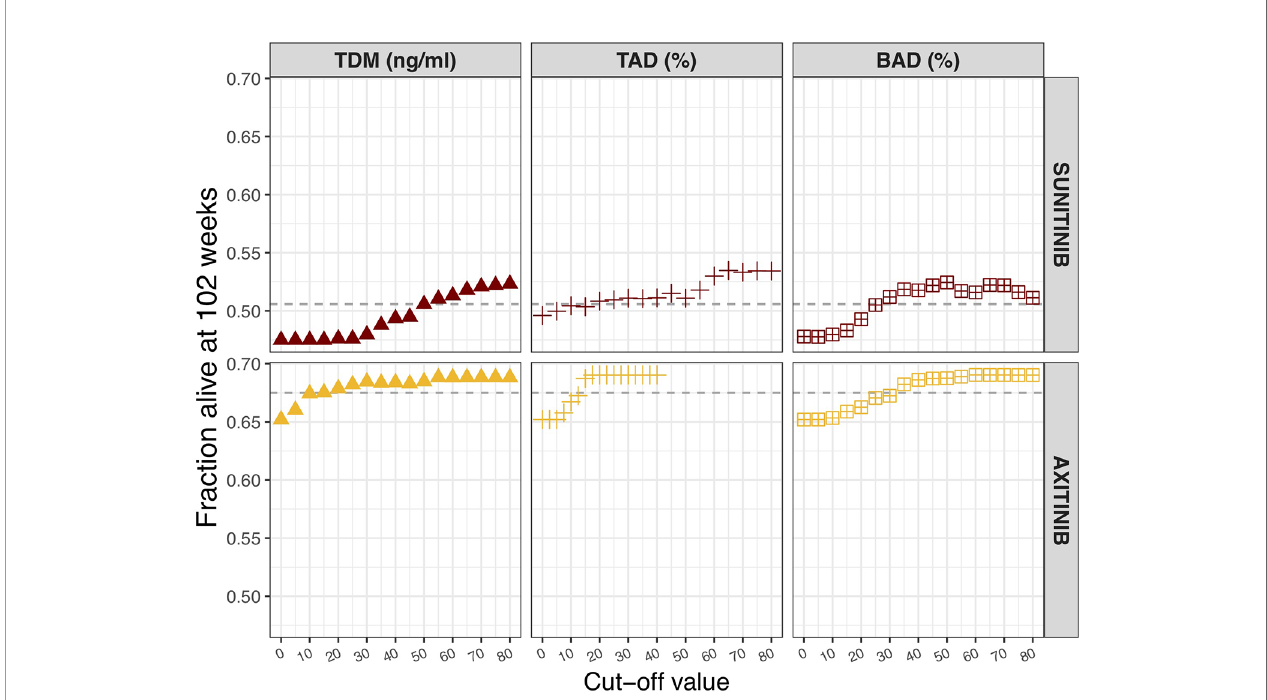
FIGURE 2 | In fl uence of biomarker threshold values on population overall survival at 102 weeks. For TDM of sunitinib (sunitinib and SU1266) and axitinib C trough,ss values of 0 to 80 ng/ml were assessed. For TAD based on neutrophils, a relative decrease from 0 to 80% from the population baseline value (5 × 10 9 cells/L) was evaluated. In case of TAD based on dBP, relative increase of 0 to 40% from individual baseline value was chosen. For BAD of sVEGFR-3, relative decrease from 0 to 80% of individual baseline value was assessed. BAD, biomarker-adjusted dosing; TAD, toxicity-adjusted dosing (ANC for sunitinib; dBP for axitinib); TDM, therapeutic drug